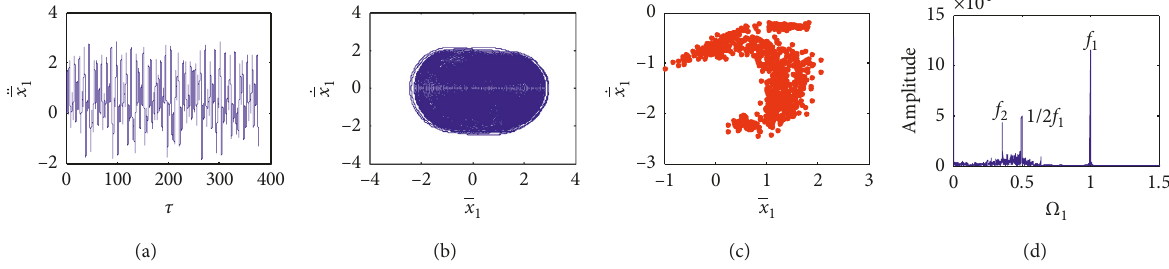
Figure 7: Vibration characteristics when Ω � 1.3: (a) time domain, (b) phase diagram, (c) Poincar´e section, and (d) frequency domain. 1